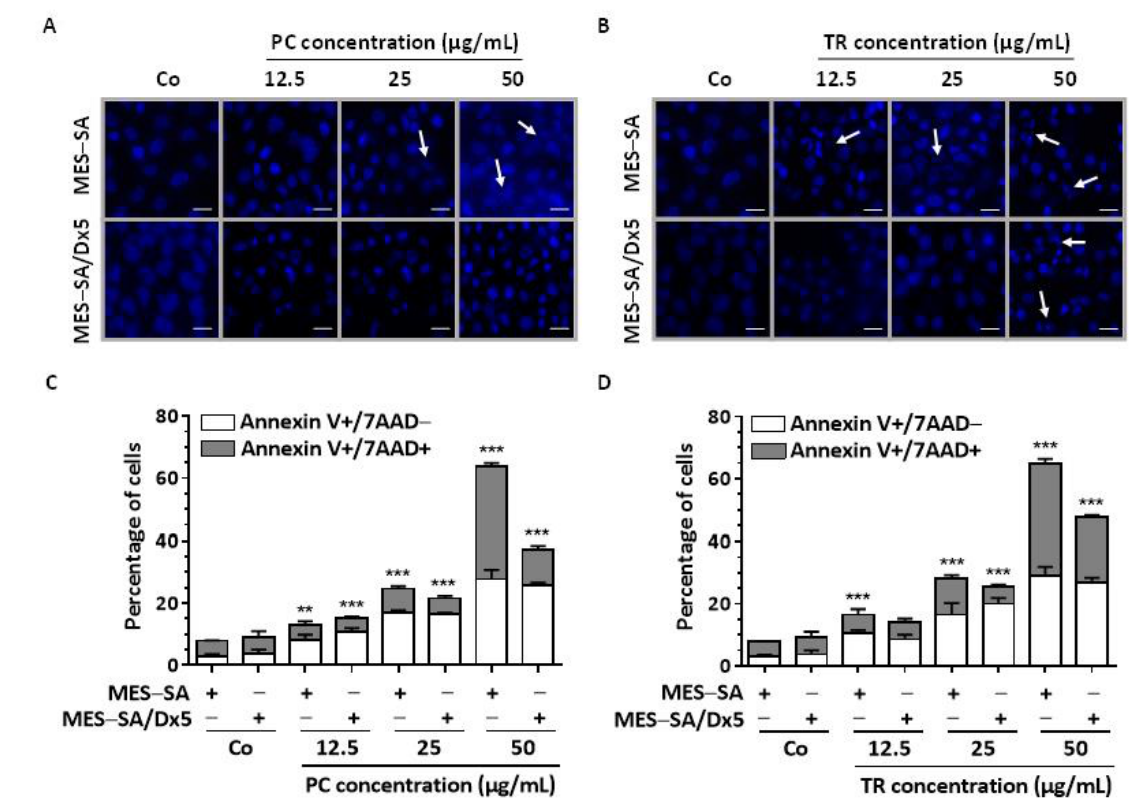
Figure 6. Pituranthos chloranthus (PC) and Teucrium ramosissimum Desf. (TR) extracts induce apoptosis of MES-SA and MES-SA/Dx5 cells. ( A , B ) Both uterine sarcoma MES-SA and MES-SA/Dx5 cell lines were stained with Hoechst 33342 after a 72 h treatment with vehicle (dimethyl sulfoxide, DMSO; Control, Co) or the indicated concentrations of PC ( A ) and TR ( B ). Representative fluorescence microscopy images of three independent experiments are shown (×40 magnification, scale bar = 10 µm). White arrows indicate typical condensed/fragmented apoptotic nuclei. ( C , D ) MES-SA and MES-SA/Dx5 cells were incubated for 72 h with medium containing vehicle (Co) or increasing concentrations of PC and TR, followed by annexin V/7-amino-actinomycin D (7AAD) staining. The percentages of early apoptotic cells (identified as the annexin V-positive/7AAD-negative population, white bar) and late apoptotic cells (identified as the annexin V-positive/7AAD-positive population, grey bar) were calculated after PC ( C ) and TR ( D ) treatment with the indicated concentrations for 72 h. Data are means ± Standard Deviation (SD) of three independent experiments; p -values were determined by a two-way ANOVA followed by Tukey’s multiple comparison test. ** p < 0.01, and *** p < 0.001 compared to control (Co) conditions of each cell line.